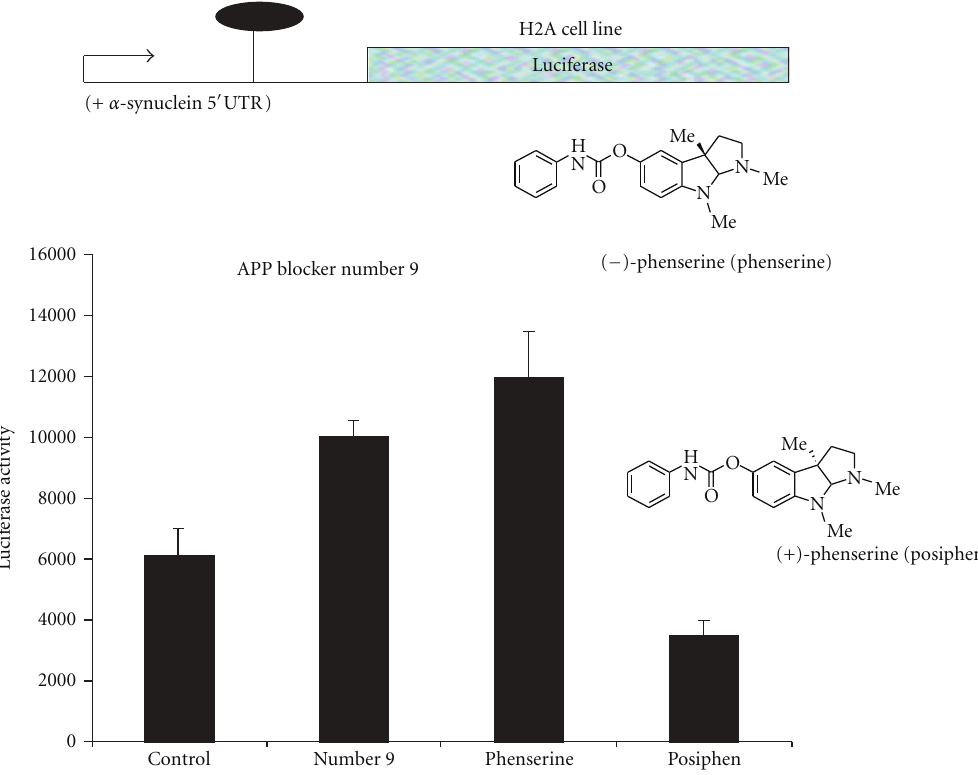
Figure 3: Posiphen is a stereospecific inhibitor of alpha synuclein 5 (cid:2) UTR-directed translation. Transient transfection assays with the SNCA - 5 (cid:2) UTR-pGL3 construct (H2A cell line). Posiphen was a highly selective inhibitor (10 μ M) of α -synuclein 5 (cid:2) UTR-driven expression of a luciferase reporter gene. This stereoisomer of phenserine inhibited α -synuclein 5 (cid:2) UTR-driven luciferase expression in neural cells ( SNCA 5 (cid:2) UTR-positive transfected neural cells ( N = 7)). By contrast, phenserine and the known APP-specific translation number 9 blocker did not suppress alpha synuclein 5 (cid:2) UTR-conferred translation in H2A cells. Phenserine and APP blocker number 9 increased SNCA 5 (cid:2) UTR- conferred translation. These data support the mechanism-of-action of posiphen as a highly selective blocker of alpha synuclein 5 (cid:2) UTR activity, whereas phenserine (same chemical structure but stereoisomer of posiphen) was previously shown selectively inhibiting translation driven by the APP 5 (cid:2)